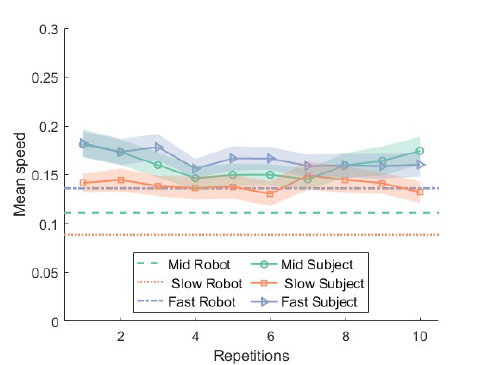
Figure 6: Mean subjects’ speed for each of the ten repetitions (“One Box”), with shaded areas representing standard error of the mean. The dashed lines represent the speeds of the robot, equal across all the ten repetitions